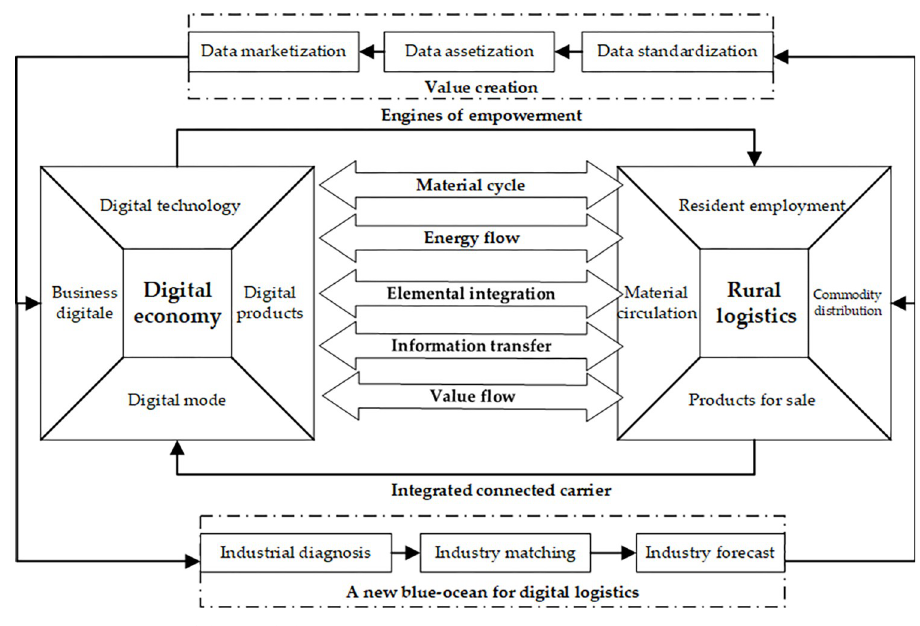
Fig 1. Composition of the coupled